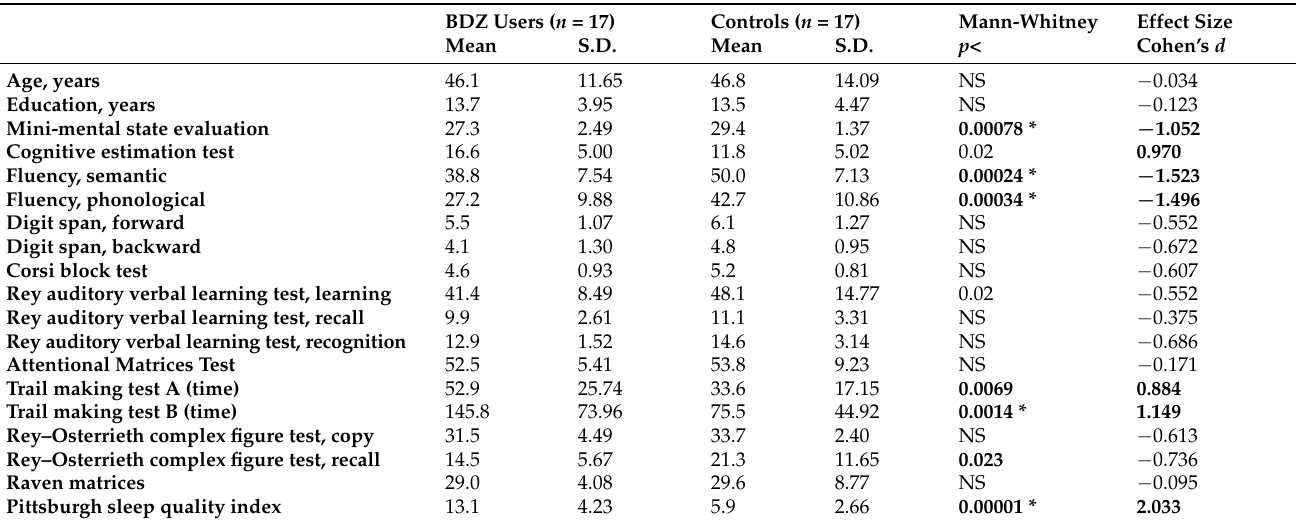
Table 1. Comparison between neuropsychological